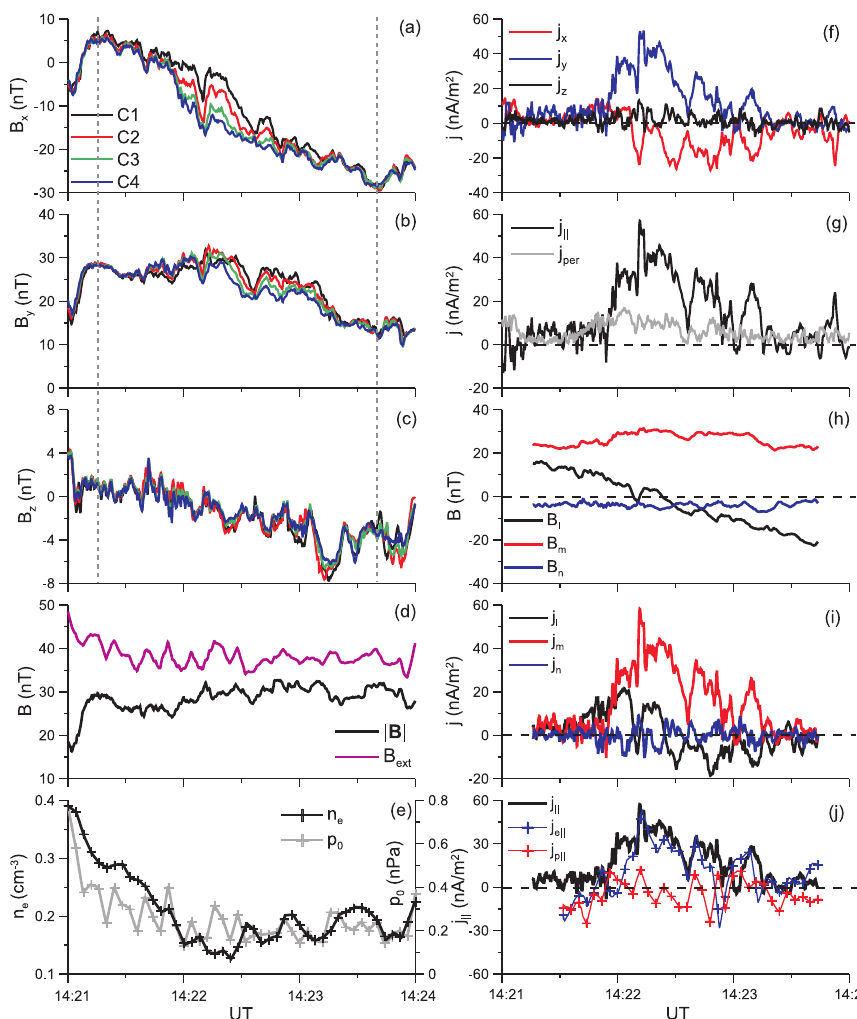
Figure 1. CS observed by the Cluster on 24 September 2003: (a) , (b) , (c) magnetic field components observed by four Cluster spacecraft; dashed lines mark the interval used to determine the local coordinate system ( l , m , n ) ; (d) the magnetic field magnitude in the barycenter | B | and in the magnetotail lobes B ext ; (e) the electron density and the total plasma pressure p 0 = n e (T e + T i ) ; (f) the current density determined using the curlometer technique; (g) current density components parallel and perpendicular to the magnetic field; (h, i) magnetic field and current density in the local coordinate system ( l , m , n ) ; (j) field-aligned components of the curlometer, ion and electron current densities.